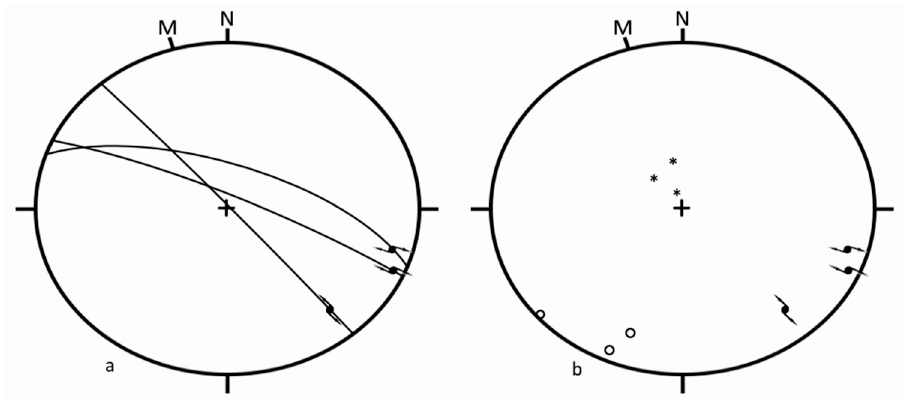
Figure 9. Regime 9. Lower Hemisphere Equal Area projection of ( a ) great circles of fault planes and ( b ) of poles to fault planes (open circles) and of calculated trend and plunge (*) of σ 2 . Symbols are as in Figure 3.